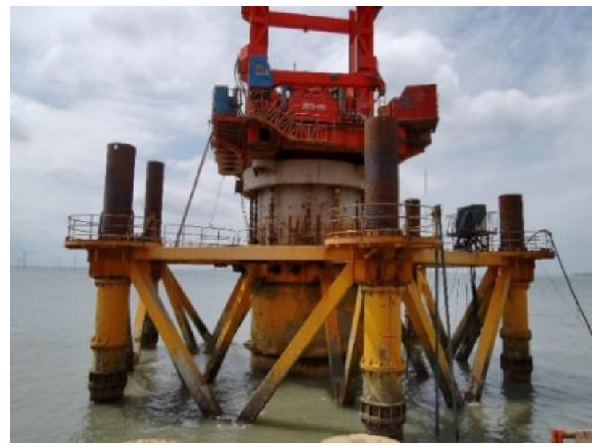
Fig. 1 The large diameter offshore drilling